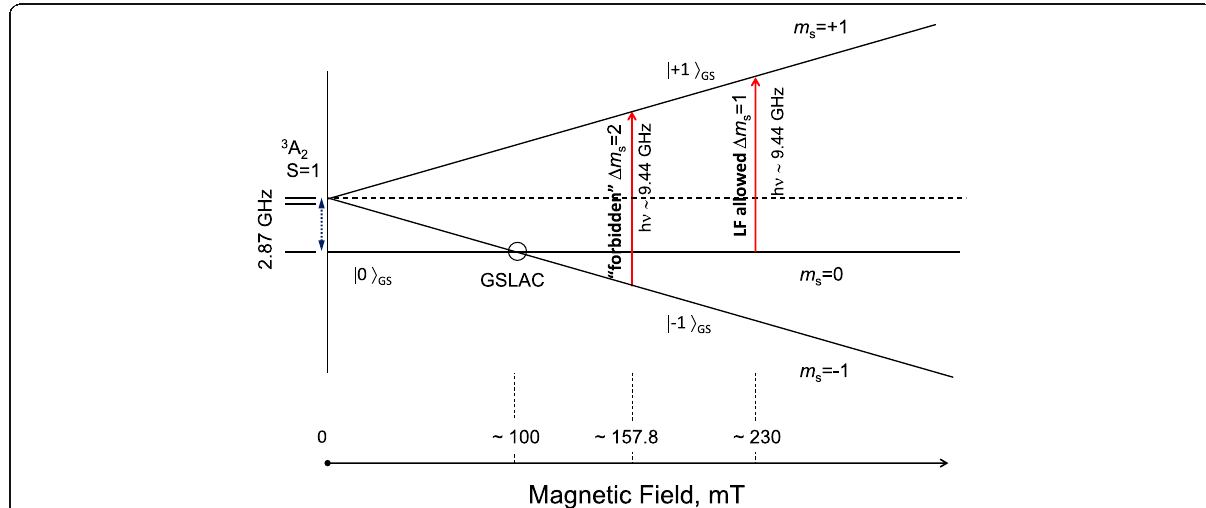
Fig. 3 Energy diagram of ground singlet-triplet levels 3 A 2 of NV − in magnetic field up to 300 mT. “ Forbidden ” Δ m s = 2 and LF allowed Δ m s = 1 transitions caused by absorption of microwave radiation ( ν ≈ 9.44 GHz) are marked by vertical red arrows. The position of the ground state spin level anti-crossing (|0 〉 GS and | − 1 〉 GS ) is marked by a